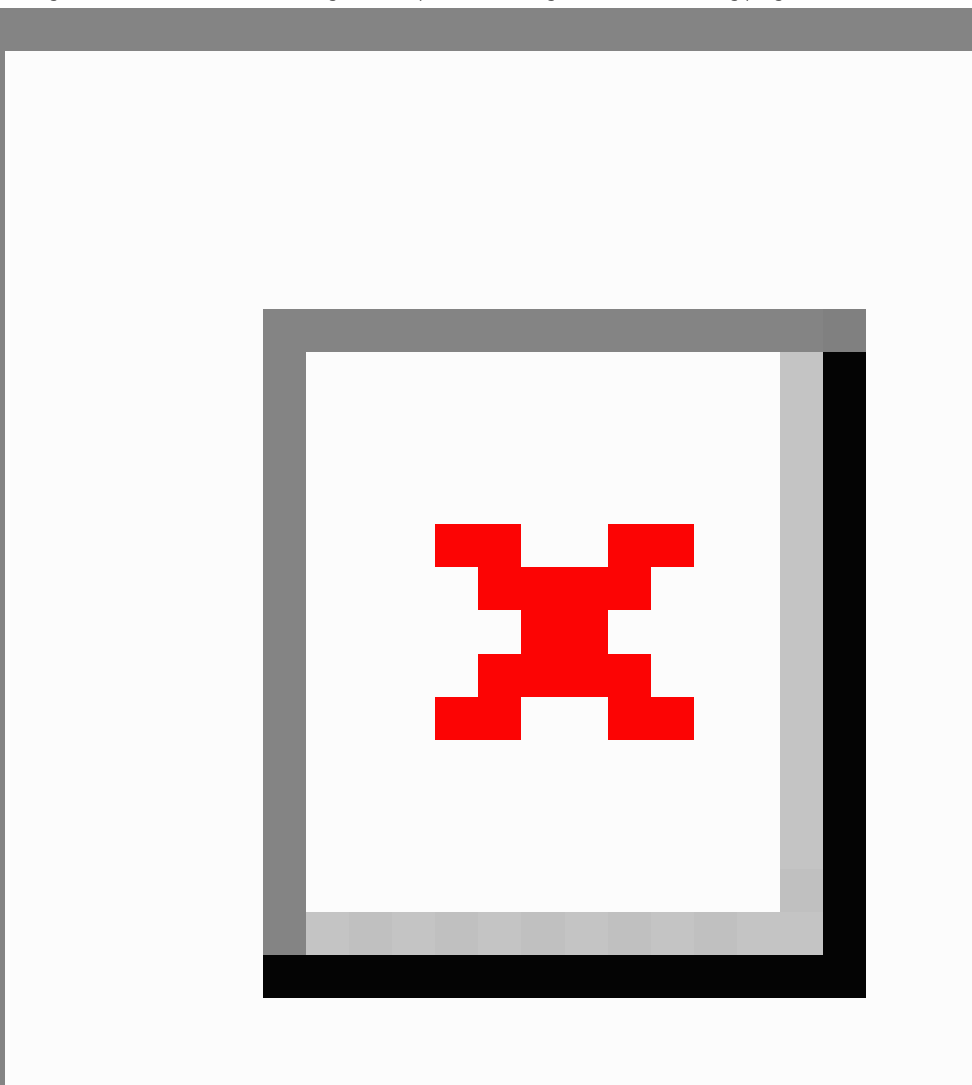
Figure 3. Progression of the number of training sessions per week during the 16-week walking